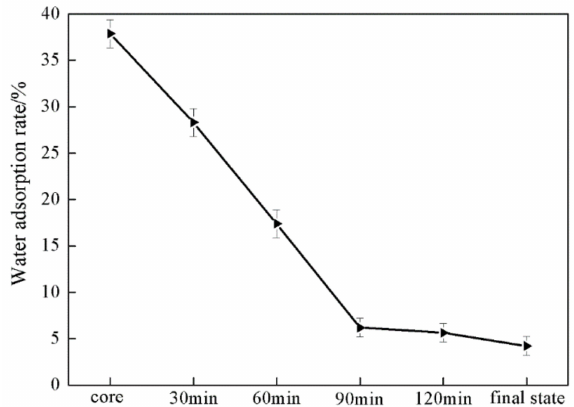
Figure 7. Effect of shell polymerization time on the water adsorption of latex